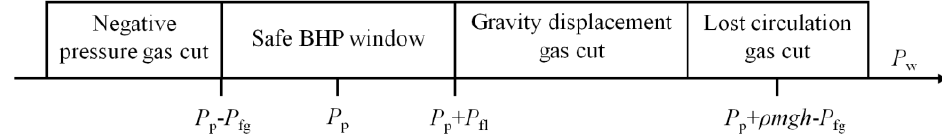
Figure 1. Number axes of gas cut, safe pressure window, gravity displacement and lost circulation at different bottom hole pressure (BHP) in a carbonate reservoir. P fl is the drilling fluid (mud) pressure for overcoming resistance and pressure drop of drilling fluid flowing from the wellbore to formation, MPa; P w is the BHP, MPa; P p is the formation pressure, MPa; P fg is the gas pressure for overcoming resistance and pressure drop of gas flowing from formation to the wellbore, MPa.